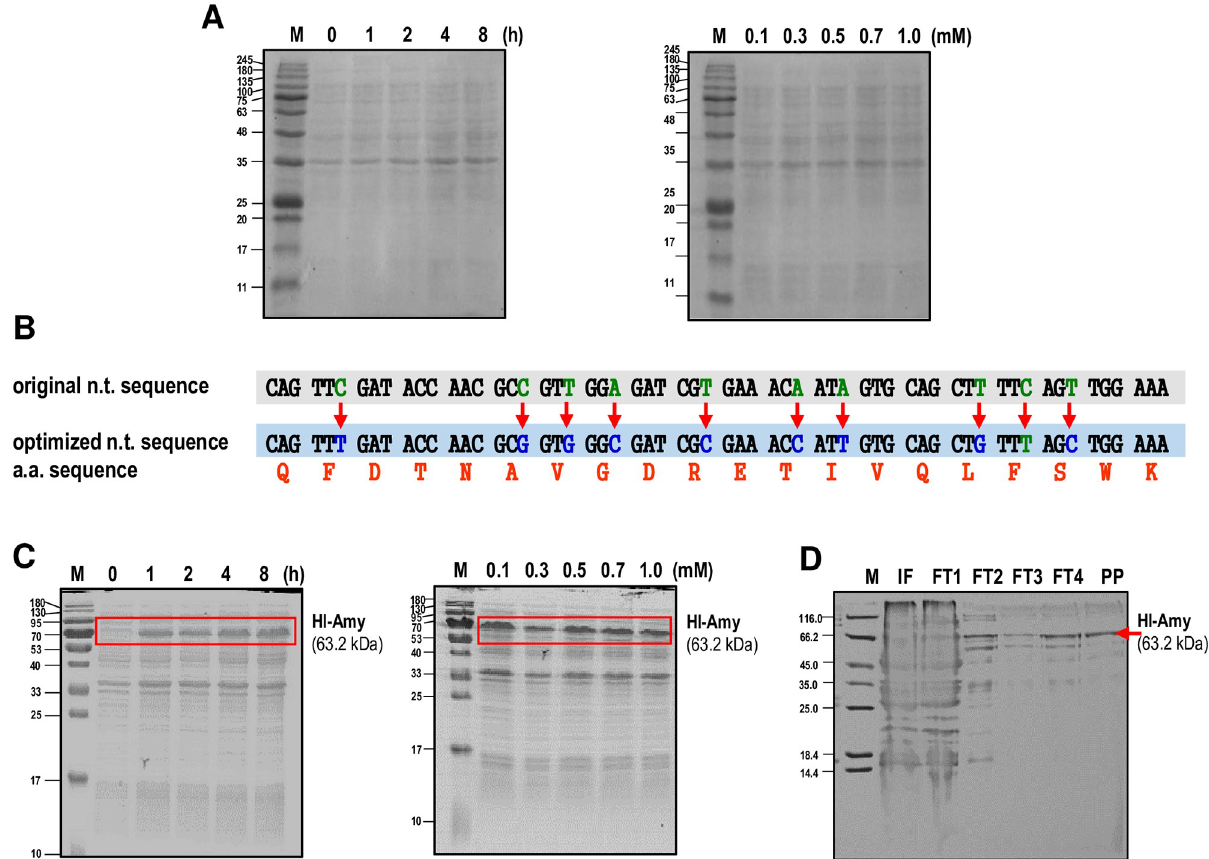
Fig 5. Expression and purification of recombination of Hl-Amy protein. A : Codon optimization of Hl-Amy mRNA. Original n. t. sequence are shown in green, while optimized n. t. sequence are shown in blue with the optimized codon were highlighted and without changing the A.A. sequence (the red letter). B : Time course of IPTG induction for recombinant Hl-Amy protein expression in BL21 E . coli with its original nucleotide sequence. C : Time course of IPTG induction for recombinant Hl-Amy protein expression in BL21 E . coli with its optimal nucleotide sequence. The cell lysates were collected from 0, 2, 4, 6, and 8 h after 1 mM IPTG induction or collected from 4 h after 0.1, 0.3, 0.5, 0.7, and 1 mM IPTG induction. D : Purification of Hl-Amy recombinant protein cell lysate with 0.5 mM IPTG induction. M: Protein marker, IF: insoluble fraction of the cell lysate, FT-1: flow-through sample after washing with binding buffer, FT-2: flow-through sample after 20 mM imidazole elution; FT-3, FT-4: flow-through sample after 50 mM imidazole elution; PP: Purified protein after 500 mM imidazole elution.